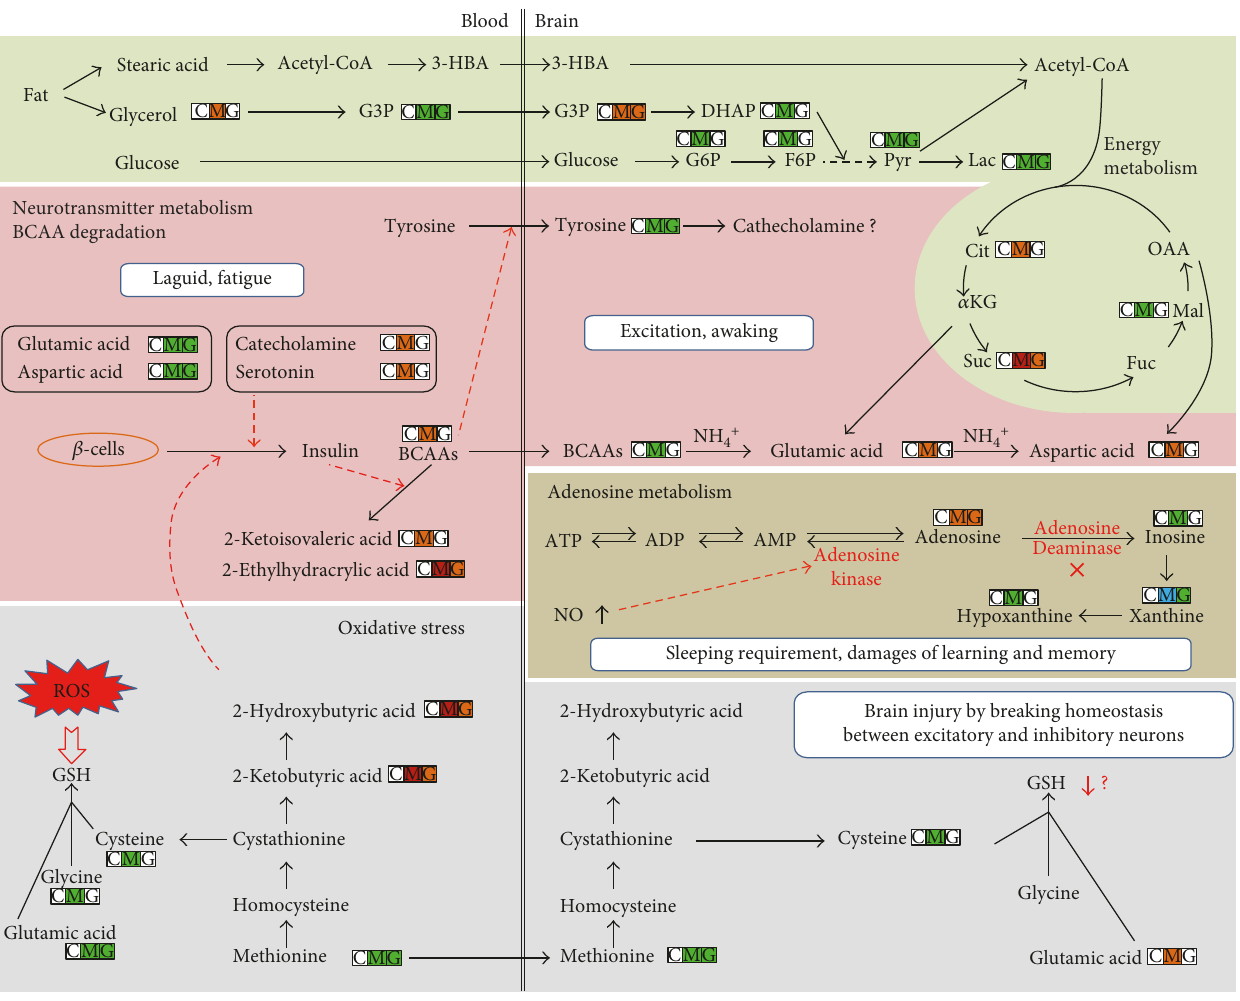
Figure 4: Proposed metabolic mechanism by SD and total ginsenoside intervention. The concentration changes are indicated in three small boxes with di ff erent colors and alphabets, where the box with “ C, ” “ M, ” and “ G ” represents WP group (as control group), model group, and GS intervention on model group. Red color indicates elevated level than WP group, while green color indicates decreased level than WP group. Red dash arrow represents